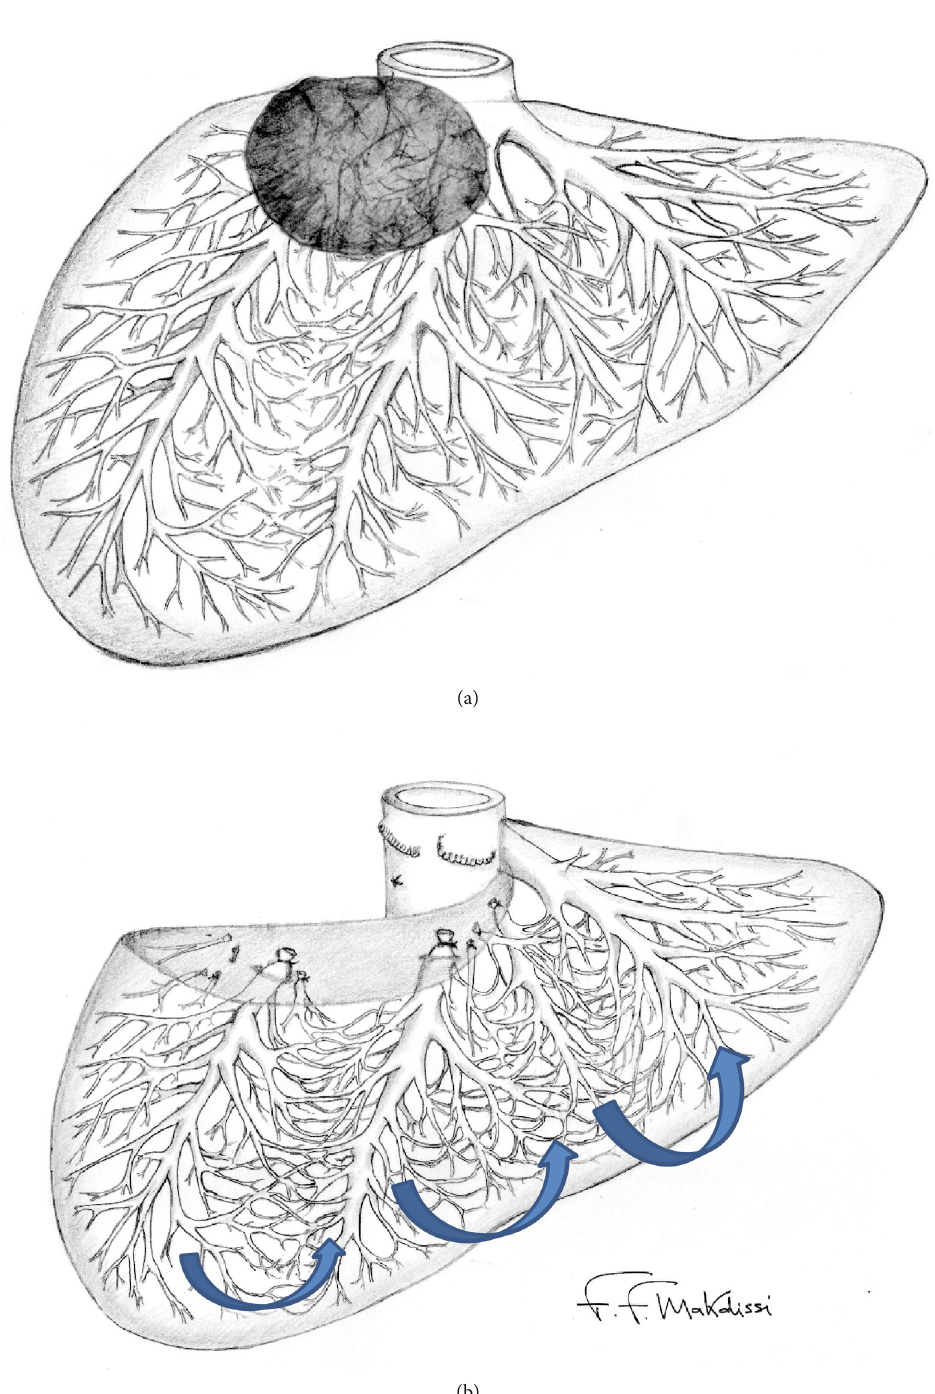
Figure 1: Collateral vein network in the absence of IRHV: (a) tumor located in segments 7-8 and 4A, with close relation or involvement of the right hepatic vein and middle hepatic vein. (b) Venous out fl ow through collaterals from the right to left communicating proximal right and middle hepatic veins with an inferior right hepatic vein and the left hepatic vein; however, it can be performed, even in the absence of a large inferior right hepatic vein (IRHV), in the presence of com- municating veins to the left hepatic vein (Figures 1(a) and 1(b)) [9, 10]. The presence of communicating veins is neces-